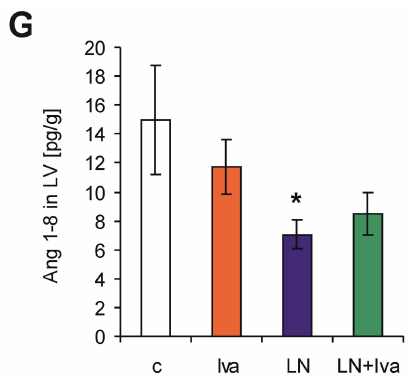
Figure 3. The influence of ivabradine (LN + Iva) on the serum level of angiotensin 1–10 (Ang I) ( A ), angiotensin 1–8 (Ang II) ( B ), angiotensin 2–8 (Ang 2–8) ( C ), angiotensin 3–8 (Ang 3–8) ( D ), angiotensin 1–7 (Ang 1–7) ( E ), angiotensin 1–5 (Ang 1–5) ( F ), and Ang II in the tissue of the left ventricle (LV) ( G ) in L -NAME-treated rats. Wistar controls (c); L -NAME (LN); ivabradine (Iva);